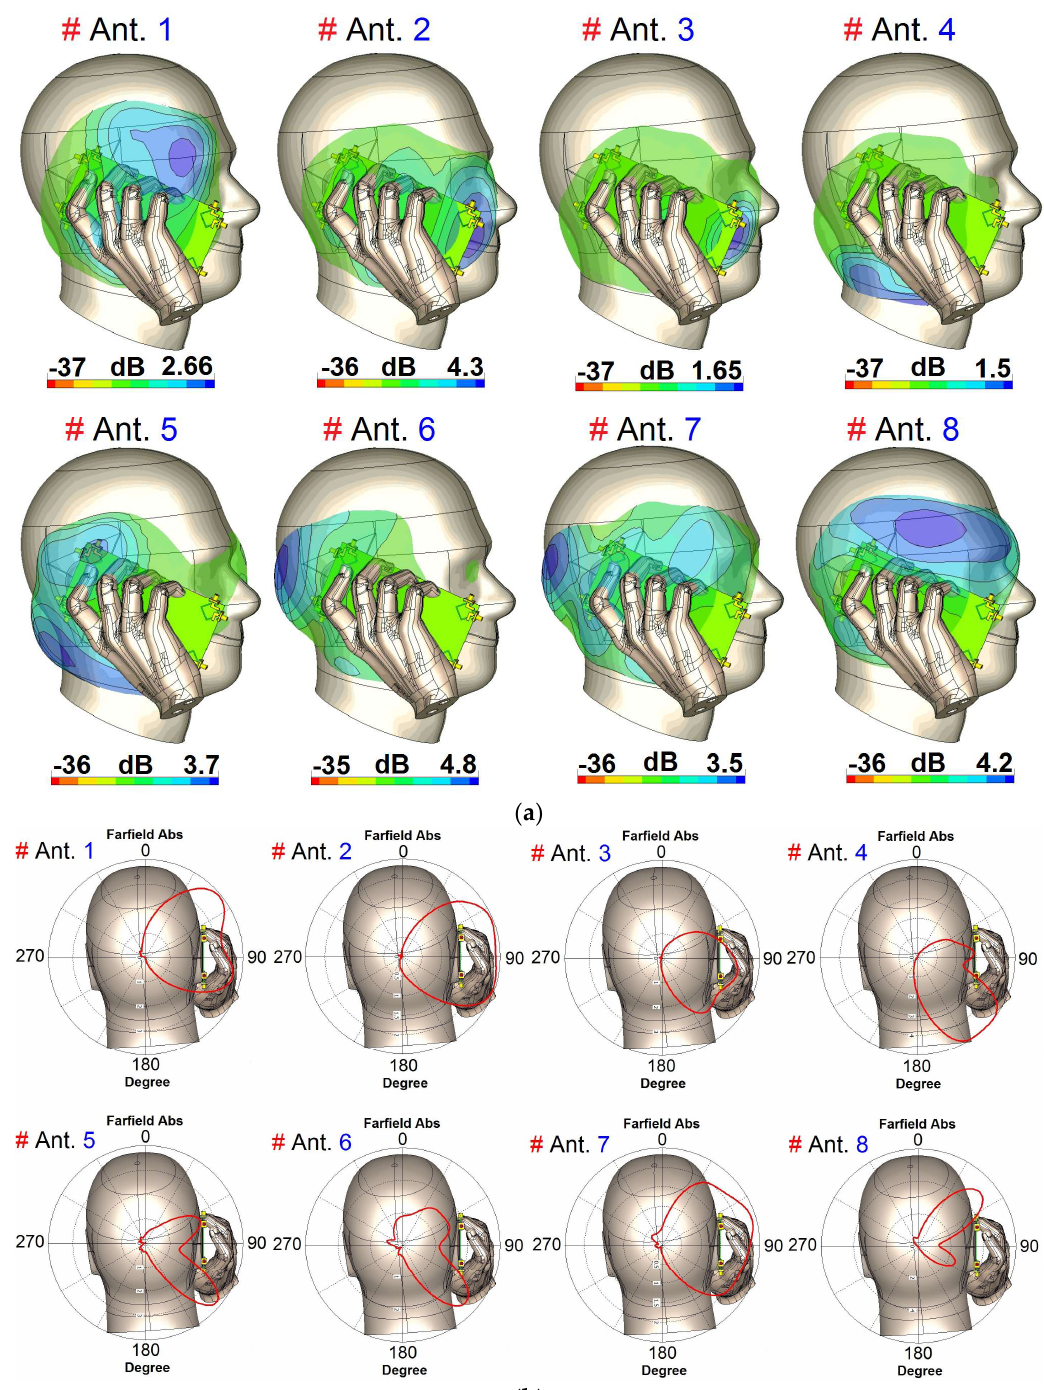
Figure 19. ( a ) 3D and ( b ) 2D linearly-scaled radiation patterns of the mobile-phone antenna in Talk-Mode scenario.